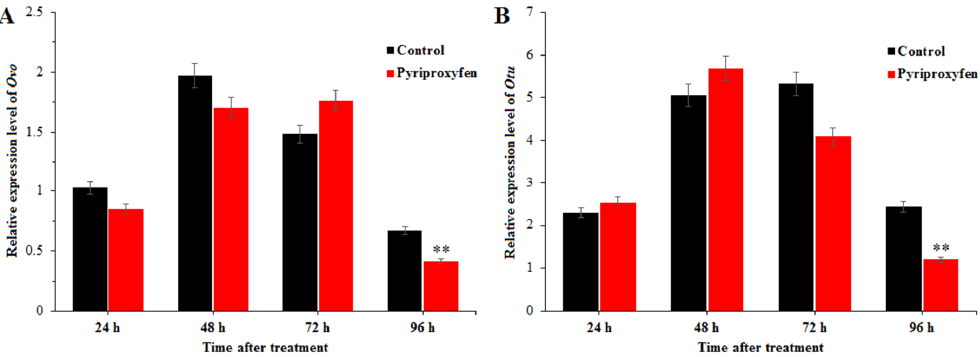
Figure 4. The effect of pyriproxyfen exposure on the expression of genes related to ovarian development: ( a ) Ovo and ( b ) Otu . The black histogram represents the control group, and the red histogram represents the treatment group. The x -axis represents the time after pyriproxyfen exposure, and the y -axis represents the relative expression level of genes. The results are shown as the mean ± SE. Asterisks denote significant differences between treatments and controls, as indicated by * p ≤ 0.05 and ** p ≤ 0.01.